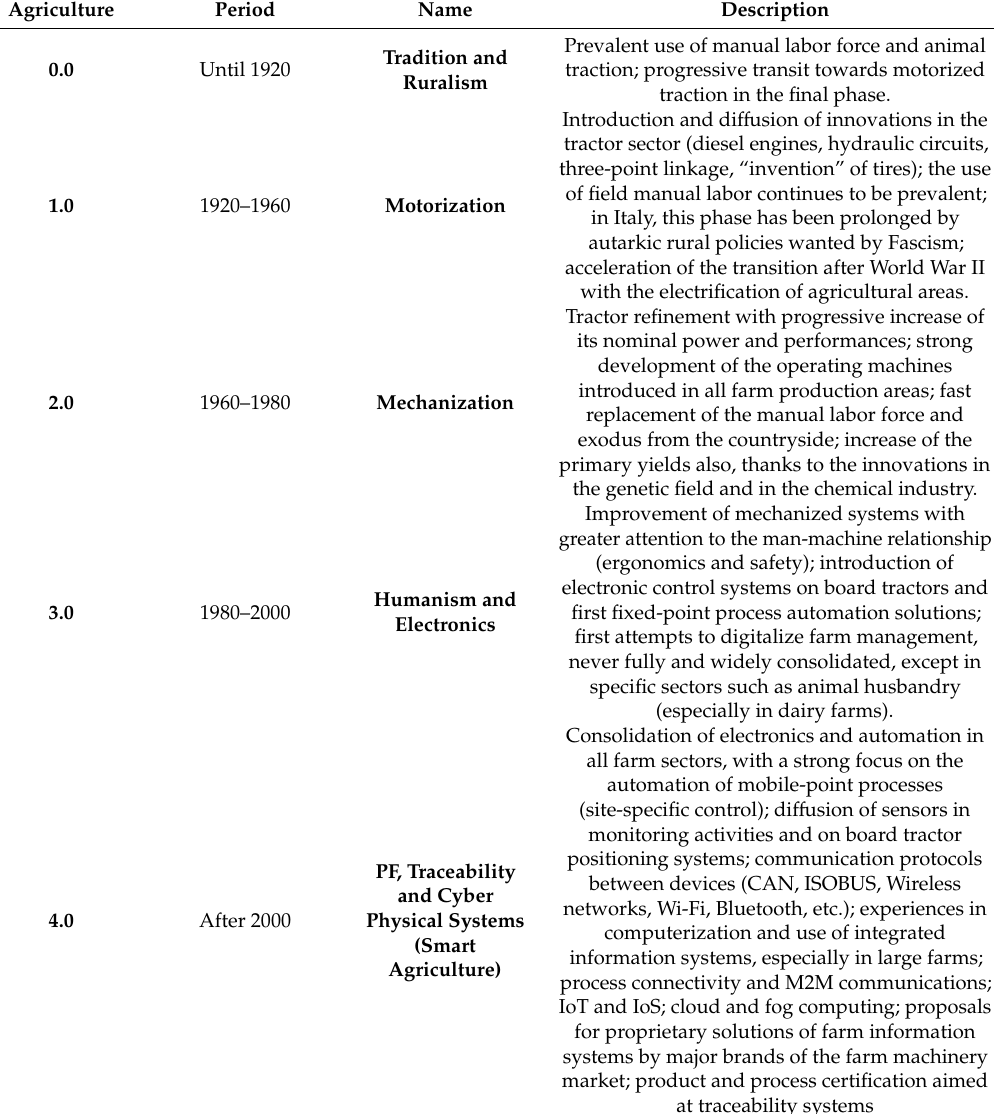
Table 1. Proposal for a possible classification of the evolutionary phases of farm technological innovations (periods derived mainly based upon the Italian